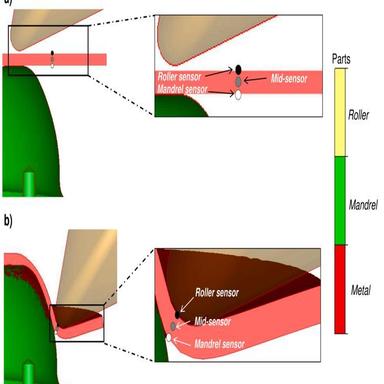
Cutting plane view during the flow forming process modeling. Location of three computational sensors (a) at initial position (b) when the roller reaches these sensors.